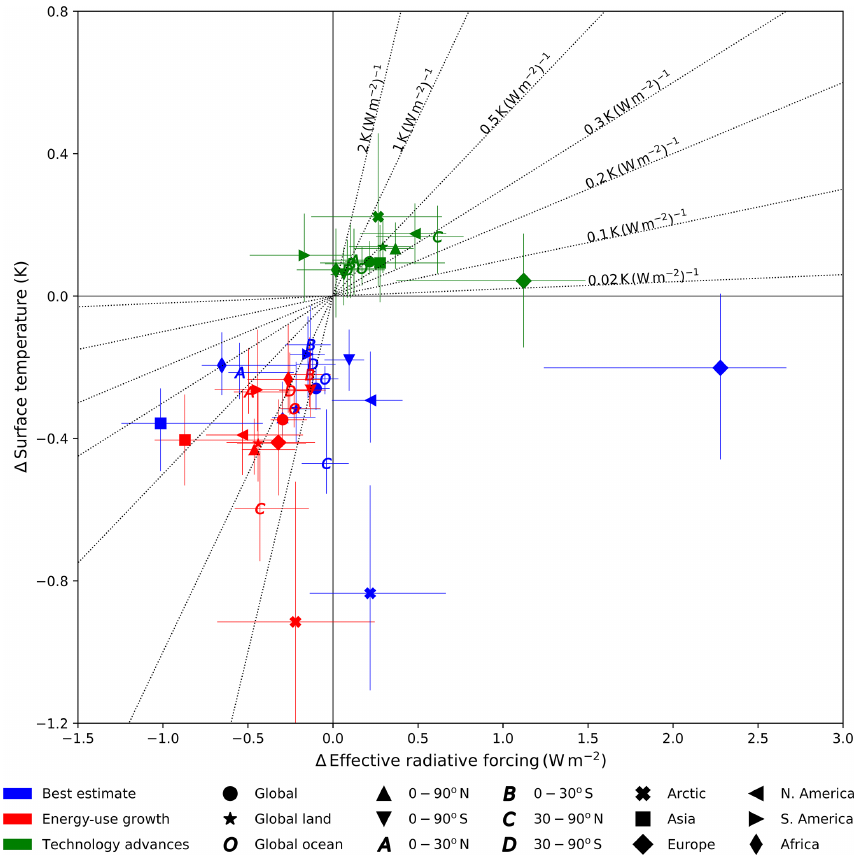
Figure 5. Scatterplot of surface air temperature responses ( (cid:49) K) vs. effective radiative forcing ( (cid:49) Wm − 2 ). The error bars represent the 25th–75th percentile spread of the model uncertainty. The dashed slope lines crossing the origin indicate the sensitivities of the temperature response to ERF (K (Wm − 2 ) − 1 ). Region definitions are as follows: Arctic (0–360 ◦ E and 60–0 ◦ N), Asia (65–145 ◦ E and 5–45 ◦ N),